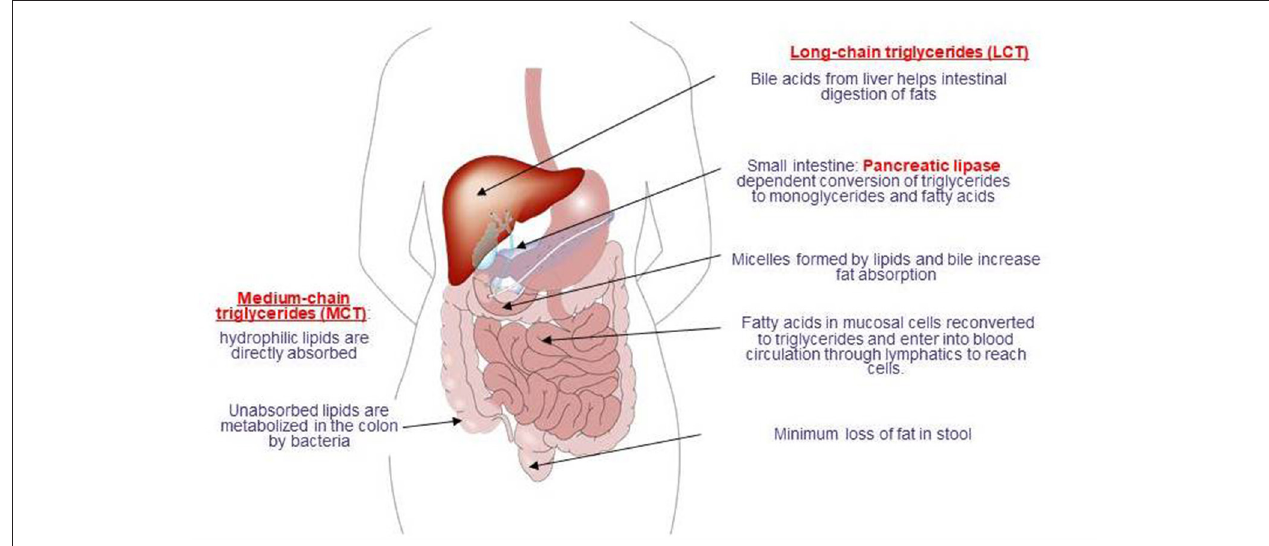
FIGURE 2 | Digestion and absorption of